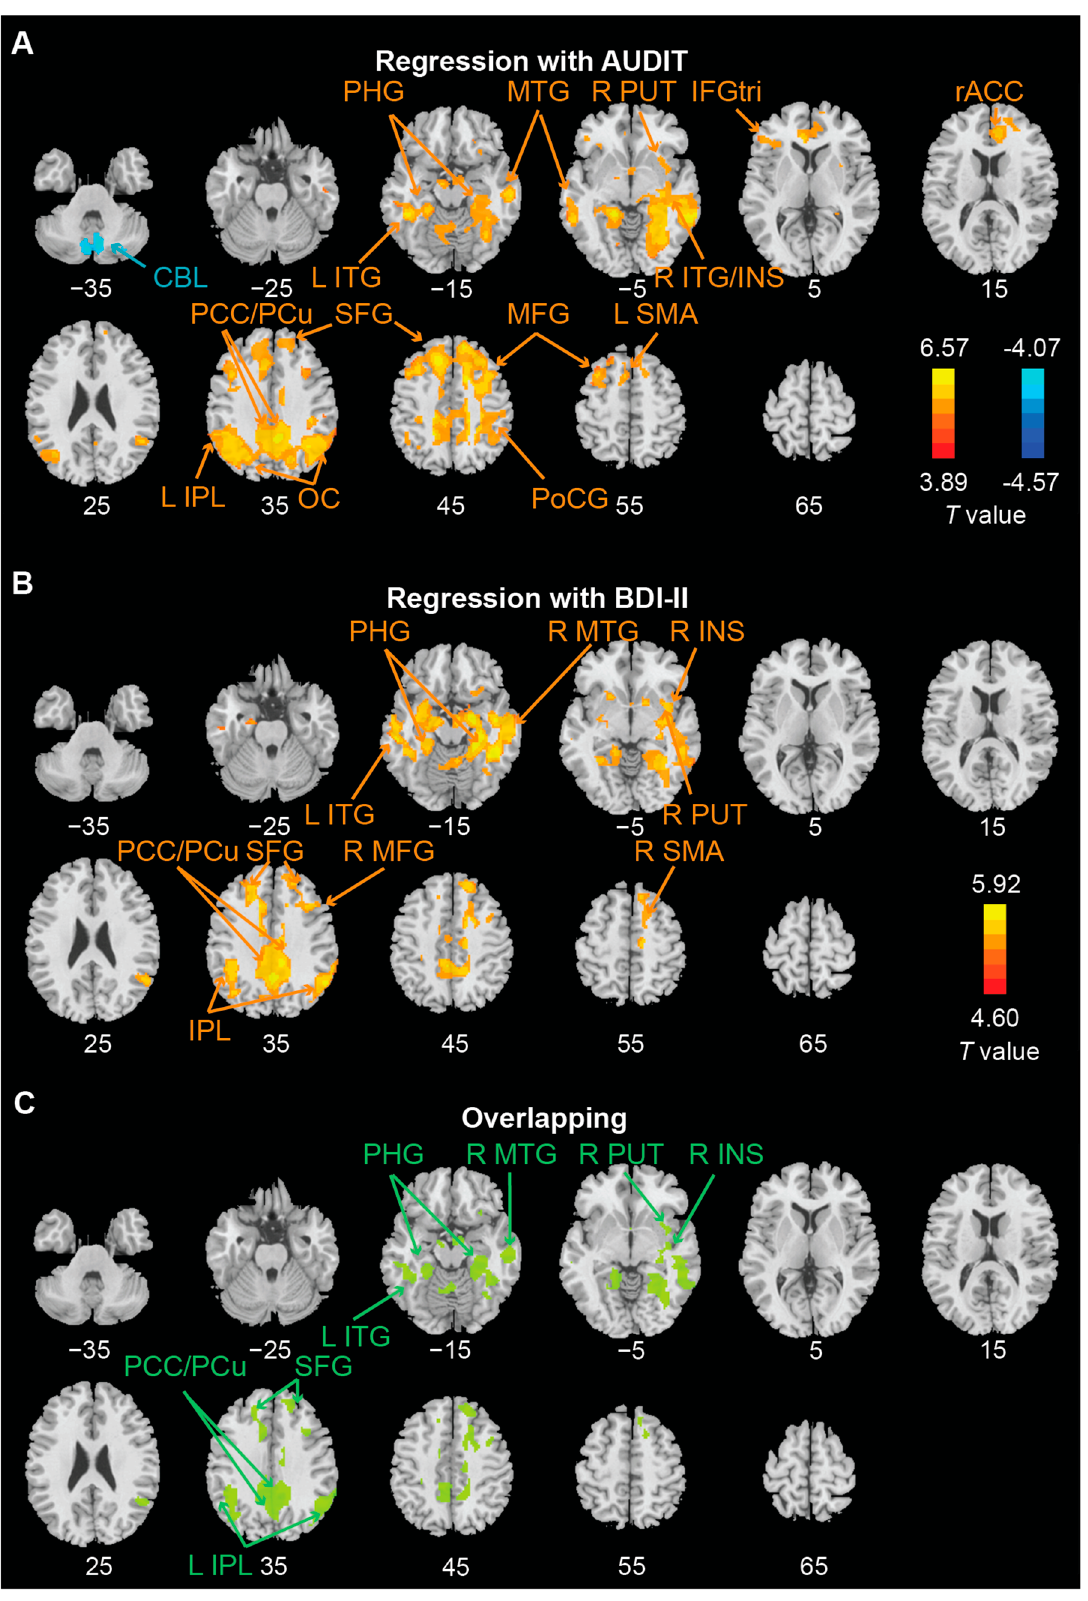
Figure 3. Regional activations to win vs. nil in correlation with ( A ) AUDIT score and ( B ) BDI-II score with age, sex, and FTND score as covariates with threshold of voxel p < 0.001 in combination with cluster-level p < 0.05 FWE corrected; The brain regions are summarized in Table 2. ( C ) ROIs overlapped of ( A , B ). Warm/cool colors indicate positive/negative correlations. L: left; R: right; CBL: cerebellum; IFGtri: inferior frontal gyrus pars triangularis; INS: insula; IPL: inferior parietal lobule;